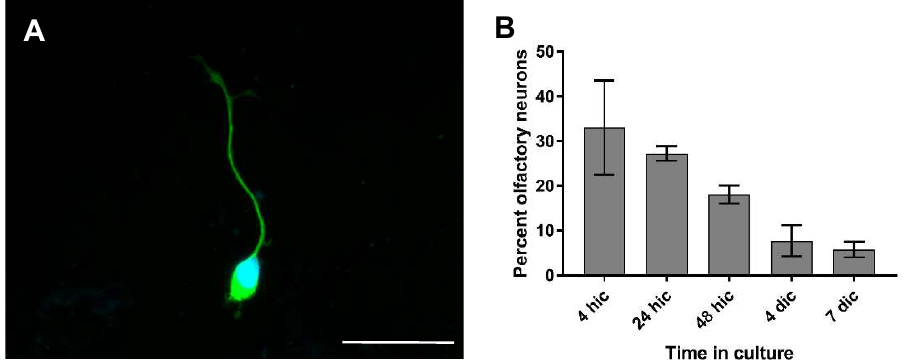
Figure 4. Immunofluorescence of the OM culture for the detection of olfactory receptor neurons (ORNs). ( A ) Olfactory neuron after two days in culture (ic). β III-Tubulin—Cy2; nuclear staining: 4’,6- diamidino-2-phenylindole (DAPI); ic—in culture. Scale bar: 20 µm. ( B ) Percentage of olfactory neurons in the primary culture of the OM over time. Arithmetic mean, error bars: standard deviation.